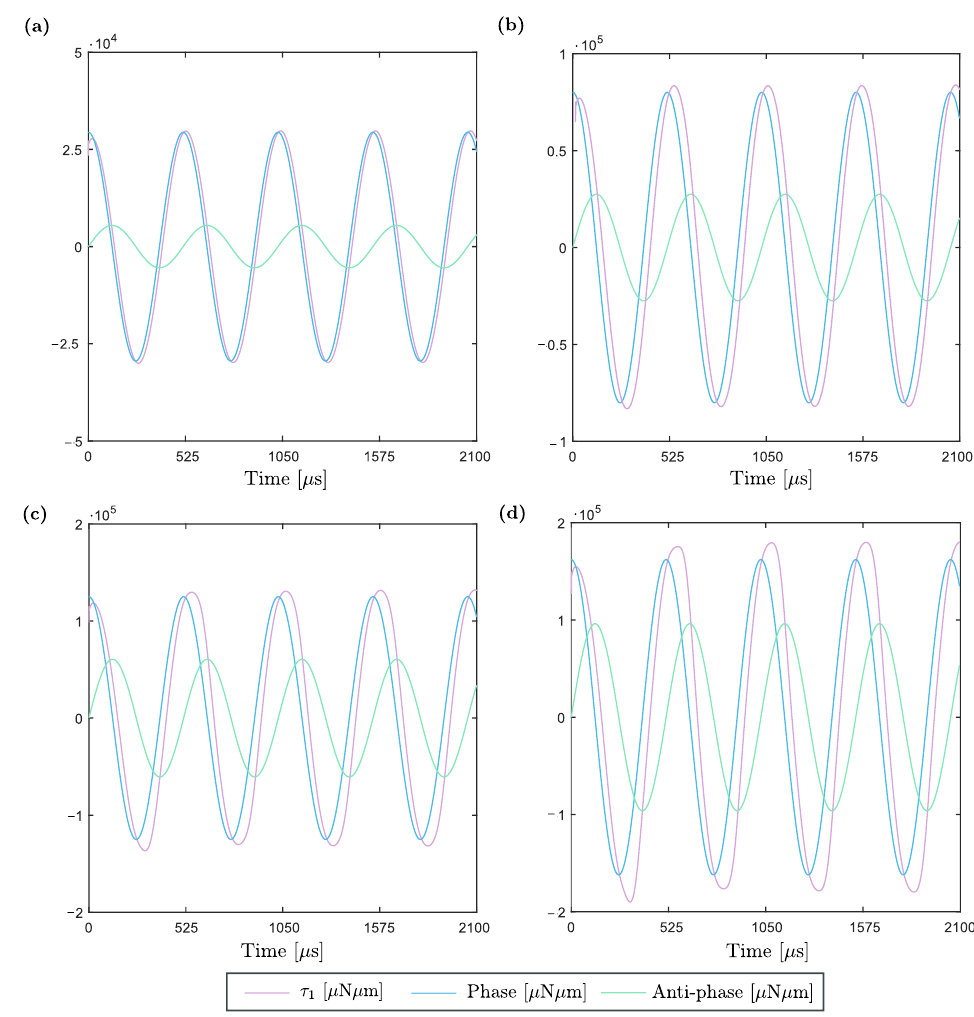
Figure 10. Component τ 1 along e 1 of the torque computed on the reflective surface of Micromirror 1. This function is periodic with frequency f 1 and with magnitude that increases along with the maxi- mum amplitude of micromirror. Moreover, τ 1 is decomposed into phase and anti-phase components with respect to the mirror rotation by applying a first order Fourier decomposition. The results are presented for α = 3.20 ◦ ( a ), α = 8.70 ◦ ( b ), α = 13.00 ◦ ( c ), and α = 16.60 ◦ ( d ). Results show that